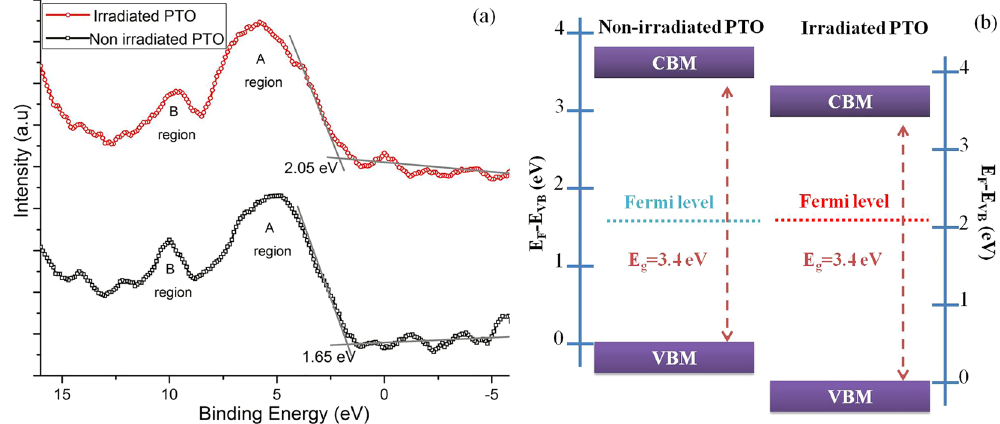
Figure 7. ( a ) valence band spectra of non-irradiated and irradiated PTO nanoparticle. ( b ) Band alignment structure of the non-irradiated PTO and irradiated